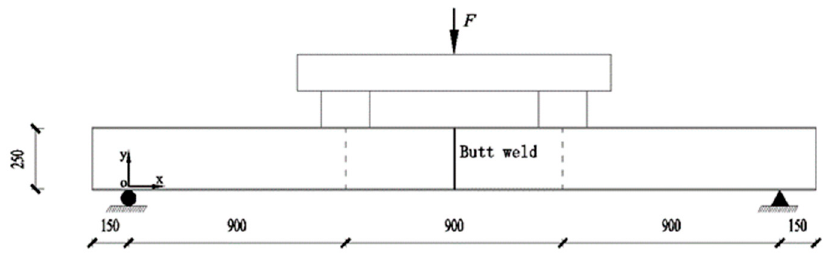
Figure 1. Schematic diagram of four-point bending loading of the specimen/unit: mm.